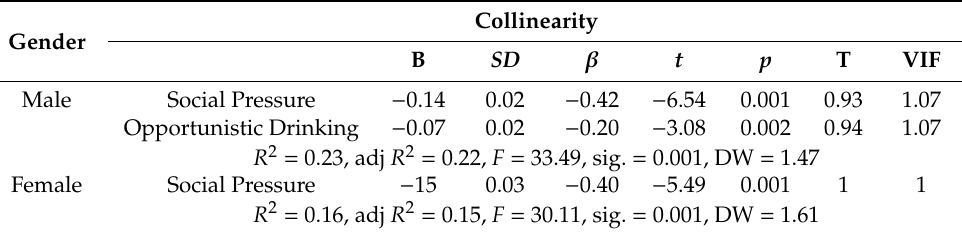
Table 4. Regression analysis of DRSE on binge drinking.